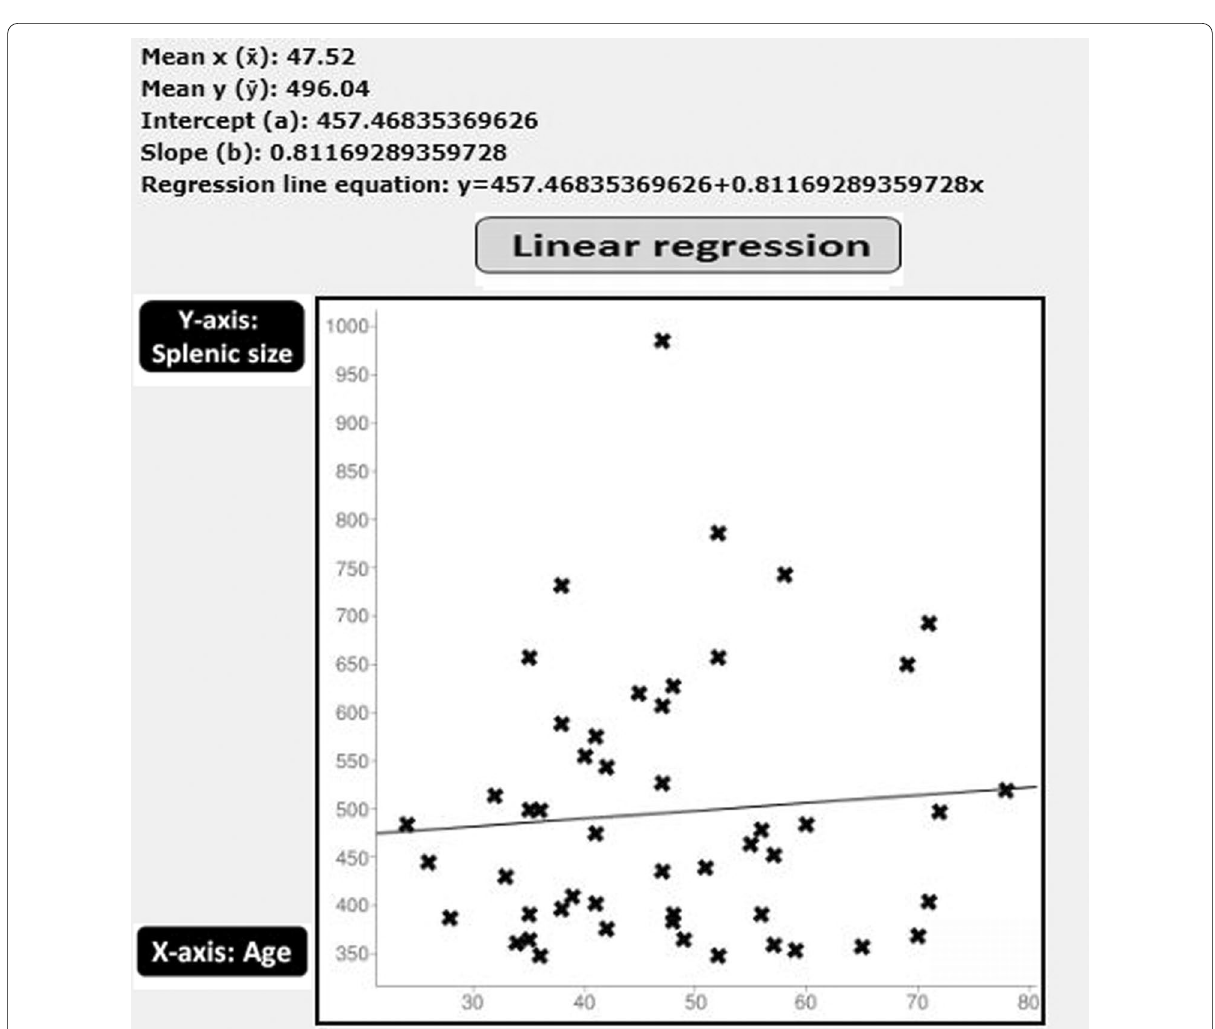
Fig. 7 Schematic presentation of Pearson correlation coefficient and linear regression analysis between the patients’ age ( X -axis) and splenic size ( Y -axis): no statistical relationship was shown ( r